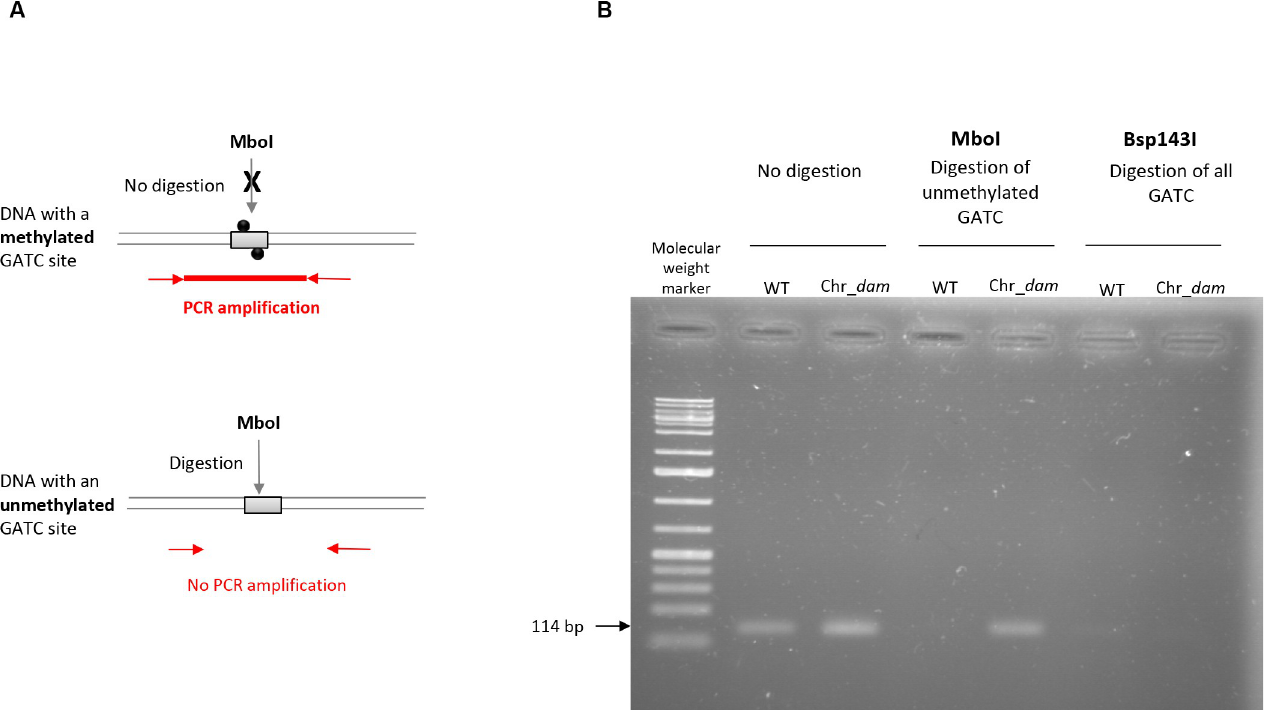
Fig 1. Methylation-sensitive restriction enzyme (MSRE) PCR analysis. (A) , MboI restriction of a DNA region with a methylated (grey box with black circles) or unmethylated (grey box) GATC site, followed by PCR amplification. (B) , PCR amplification of a locus harboring a previously found unmethylated GATC site (chromosomal position 10531) was performed on P . luminescens WT or Chr_ dam strains DNA digested by MboI or Bsp143I (which digests GATC sites, whatever the methylation state). Detection of a 114 bp amplicon revealed that no digestion occurred.